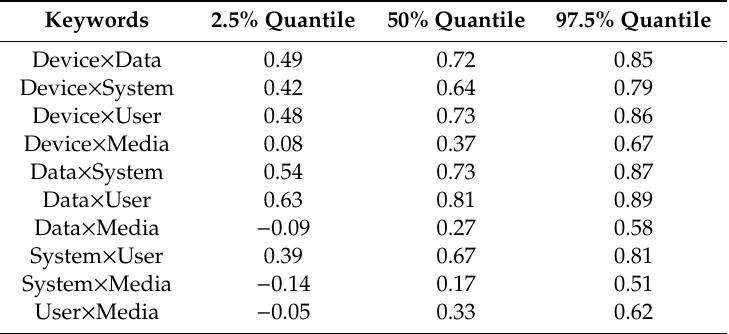
Table 3. Posterior quantiles of correlation coe ffi